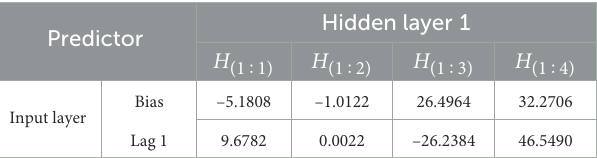
TABLE 11 Parameter estimation of FFNN model from input layer to hidden layer 1.